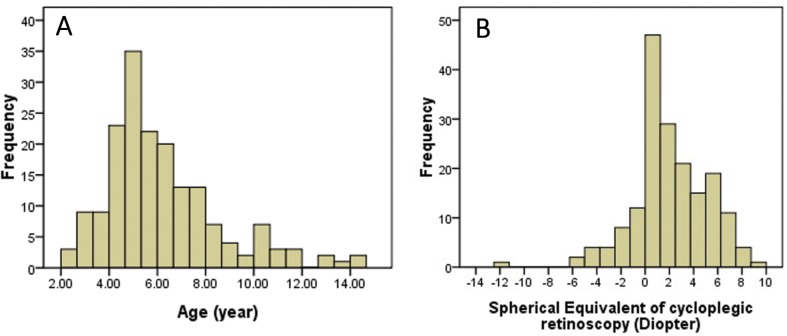
(A) Distribution of ages of the study subjects; (B) Distribution of refractive errors of the study subjects.